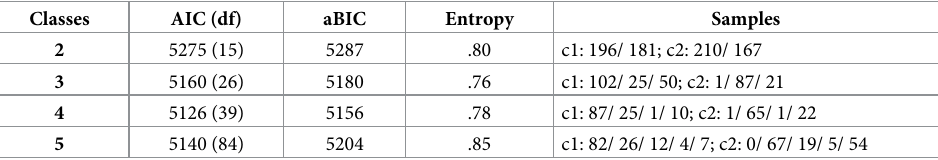
Table 4. Latent transition analysis model fit statistics to select longitudinally the number of classes of well-being at